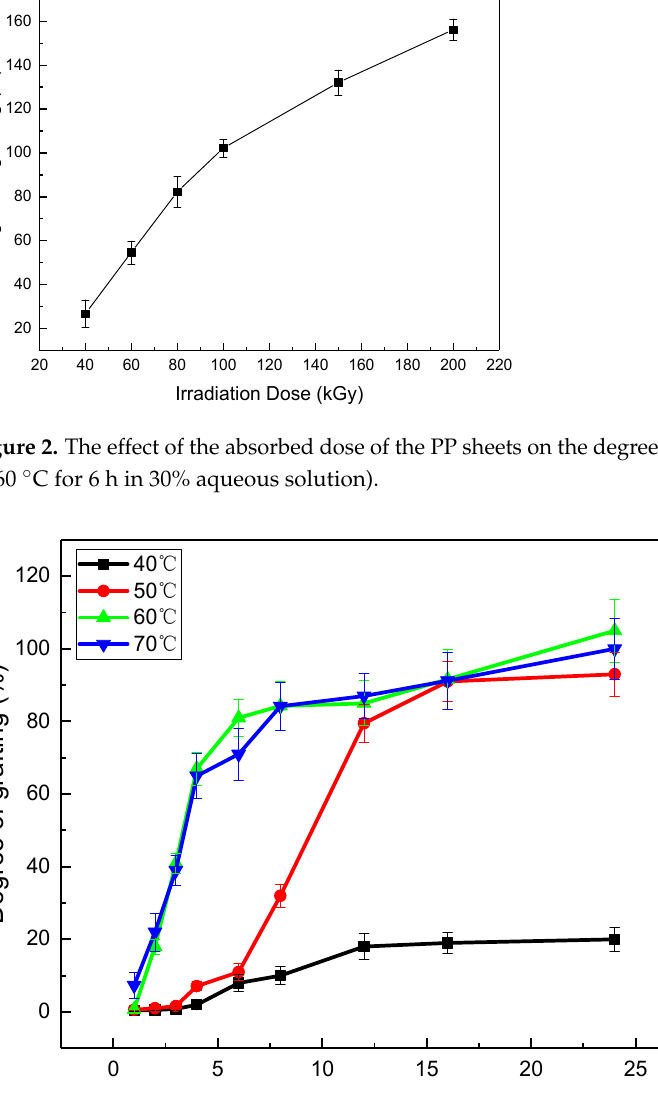
Figure 2. The effect of the absorbed dose of the PP sheets on the degree of grafting (AAm was grafted at 60 °C for 6 h in 30% aqueous solution).